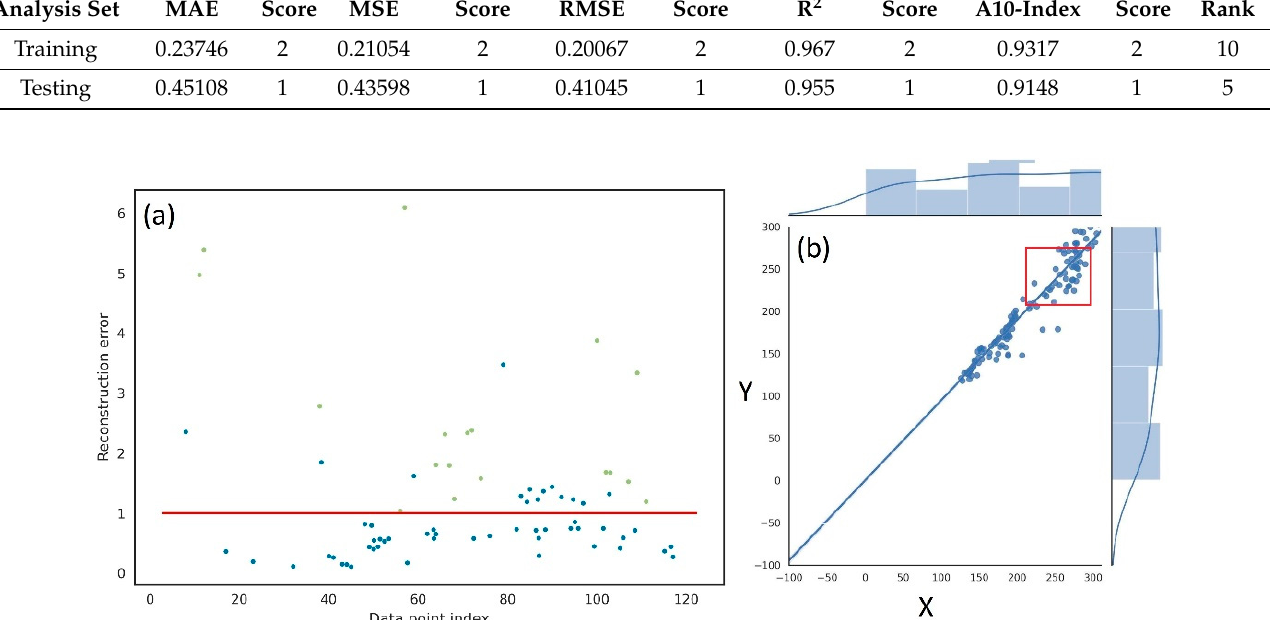
Figure 7. ( a ) Scattered and ( b ) Willmott’s index for error variations for UCS results.